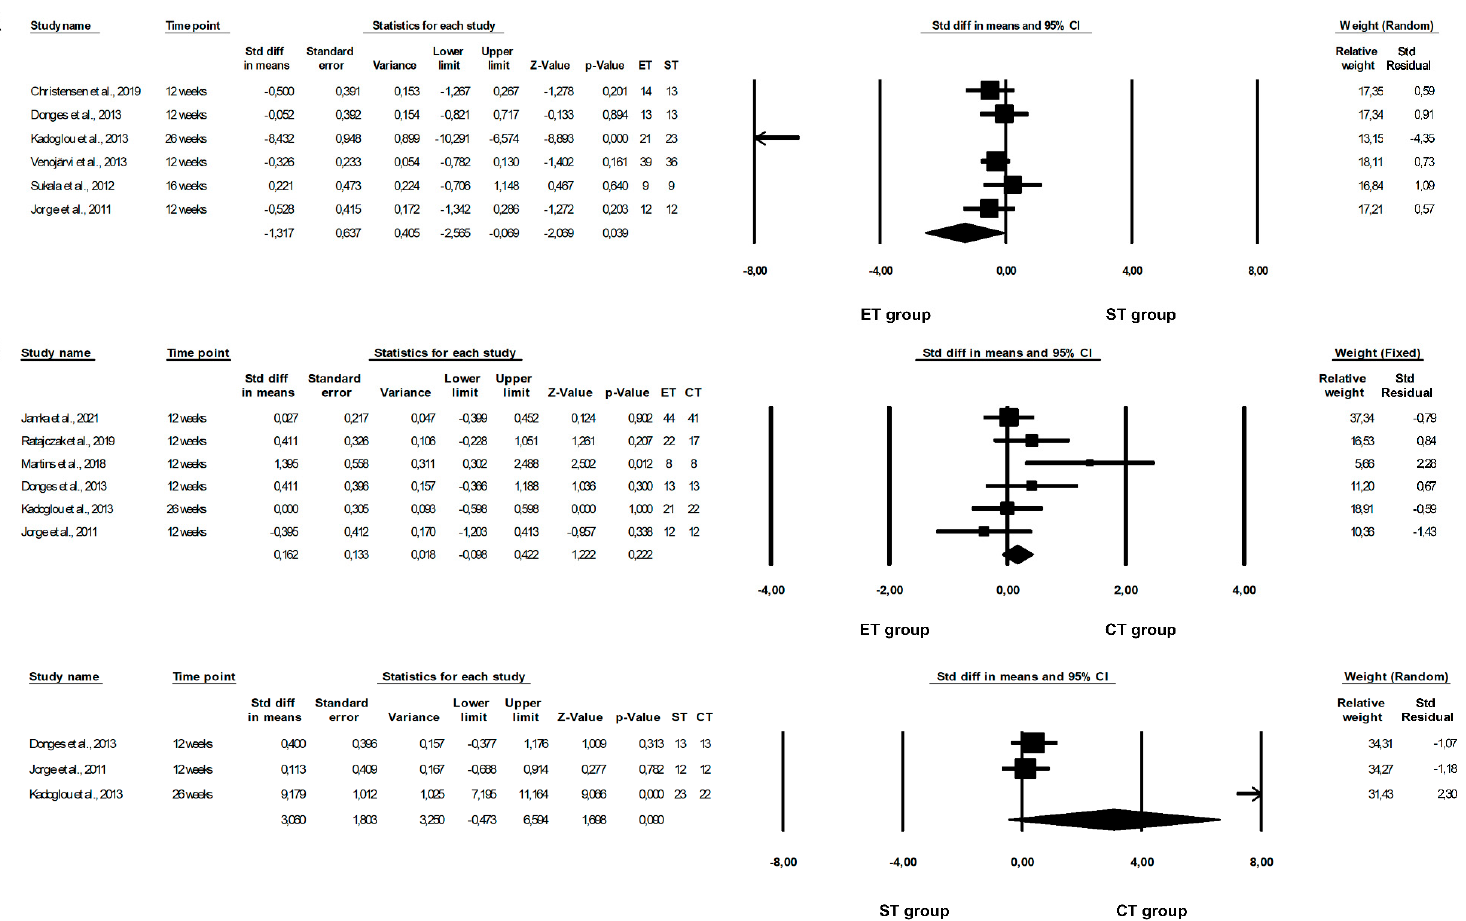
Figure 2. Forest plots of the effect of different training programmes on CRP levels: ( A ) ET vs. ST—random model; ( B ) ET vs. CT—fixed model; ( C ) ST vs. CT—random model. CI—confidence interval; CT—combined training; ET—endurance training; ST—strength training; Std diff—standard differences [14–16,21– 23,25,40,48].